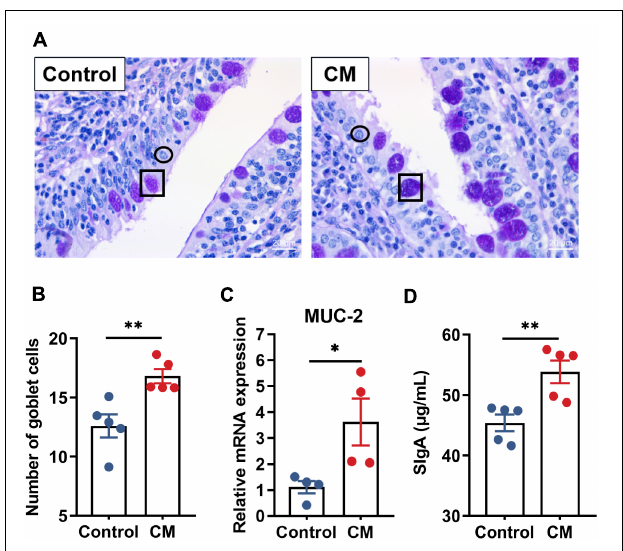
FIGURE 2 | CM improves biochemical barrier function. (A) Periodic acid Schiff (PAS) staining of the duodenum, ↔ represents goblet cells, and ↔ represents intestinal epithelial cells. (B) Count and analysis of the number of goblet cells ( n = 5). (C) RT-qPCR analysis of the mRNA expression level of MUC-2 ( n = 4). (D) ELISA analysis of the concentration of SIgA in the duodenal mucosa ( n = 5). Control, pigs fed a basal diet; CM, pigs fed the basal diet supplemented with CM at 300 mg/kg. Data are presented as the mean ± SEM. ∗ P < 0.05, ∗∗ P <